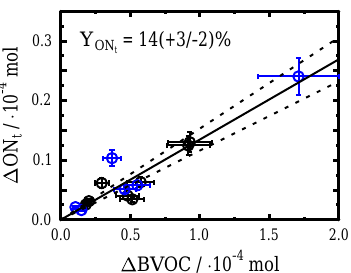
Figure 6. Total wall-loss- and dilution-corrected organic nitrate pro- duction ( (cid:49) ON t ) as a function of the amount of BVOC consumed ( (cid:49) BVOC) for the unseeded (black circles) and (NH 4 ) 2 SO 4 -seeded experiments (blue circles). The error bars and fits are derived as in Fig.